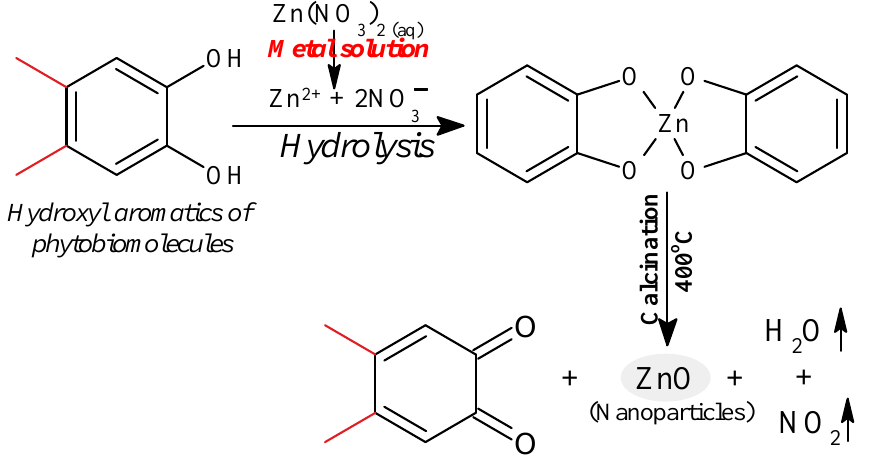
Figure 7. The chemical mechanism of ZnO nanoparticle formation.